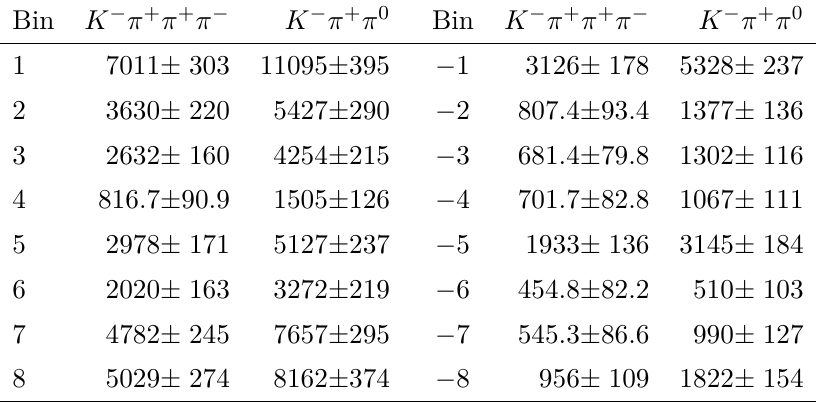
Table 4 . Efficiency corrected signal yields Y K 3 π space. The efficiencies integrated over all bins are 12.9 % and 13.6 % for D → K − π + π + π − and D → K − π + π 0 decays, respectively.